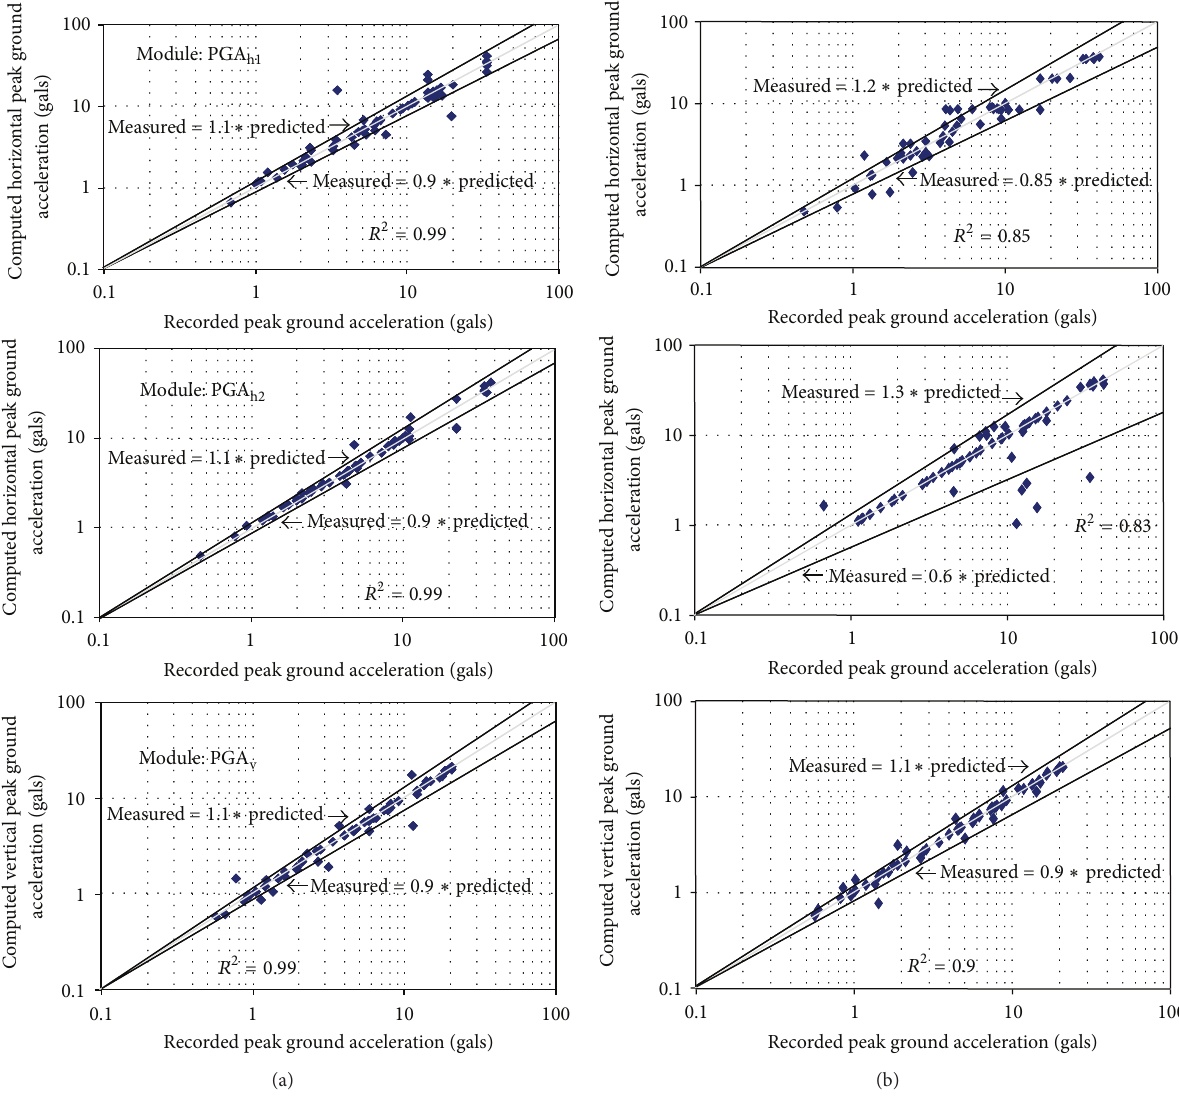
Figure 12: Comparisons between estimated and recorded peak ground accelerations for each component independently. (a) Left: training phase and (b) right: testing